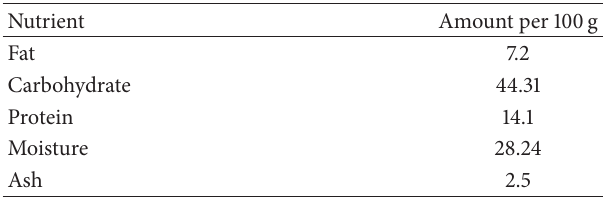
Table 1: Characteristics of soy bean flour enriched bread used in the